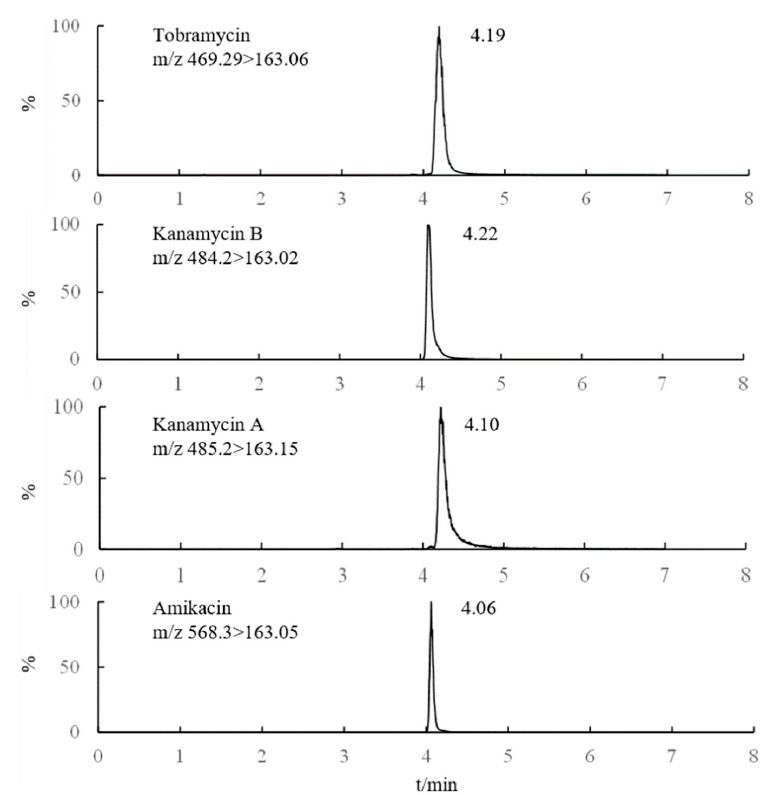
Figure 2. MRM chromatograms of 4 Ags (1 μ g/mL).